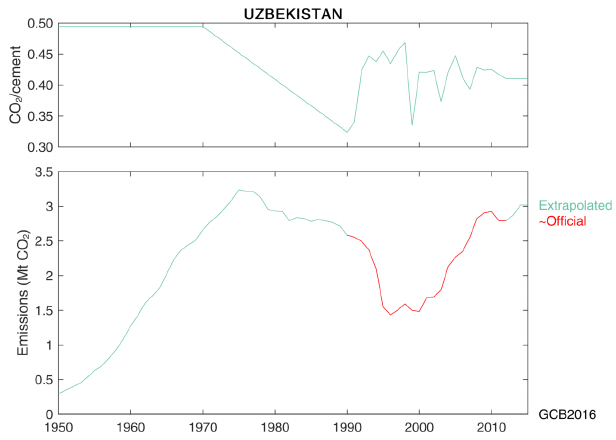
Figure D29. Revised cement emissions in Uzbekistan.